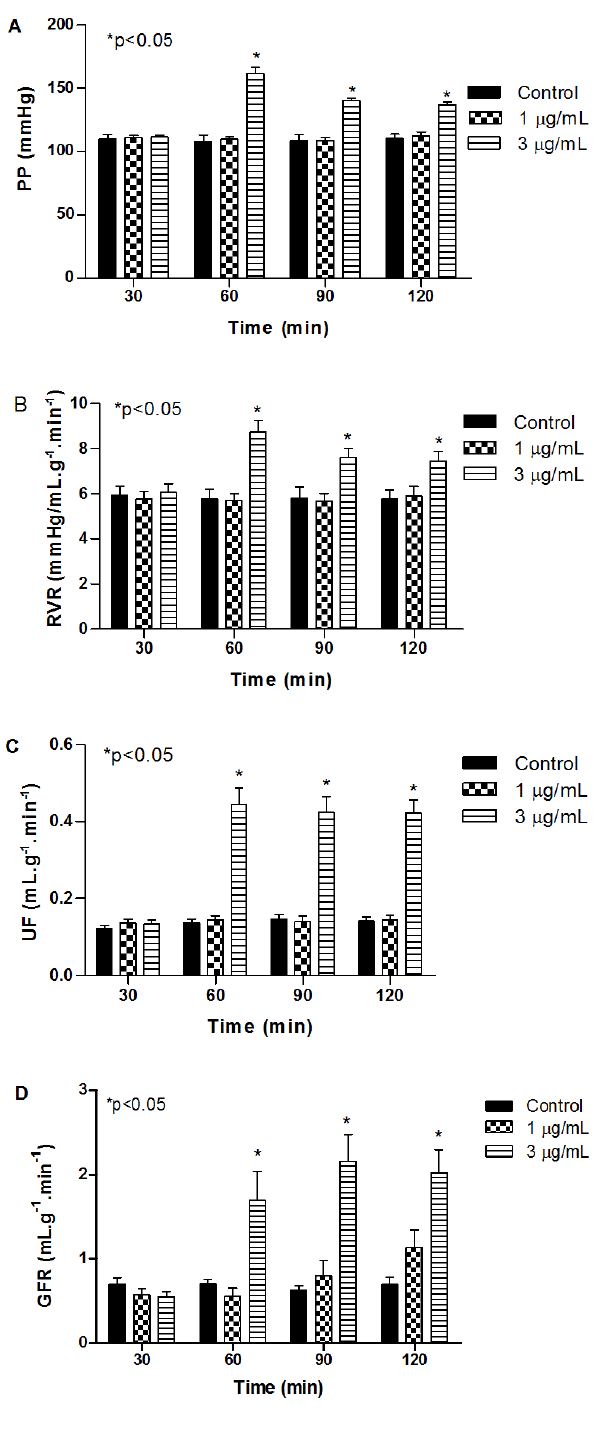
Figure 1. Effects of Polybia paulista venom (PPV; 1 and 3 μg/mL) on: ( A ) perfusion pressure (PP), ( B ) renal vascular resistance (RVR), ( C ) urinary flow (UF) and ( D ) glomerular filtration rate (GFR) at various times. Values represent means ± SEM (n =